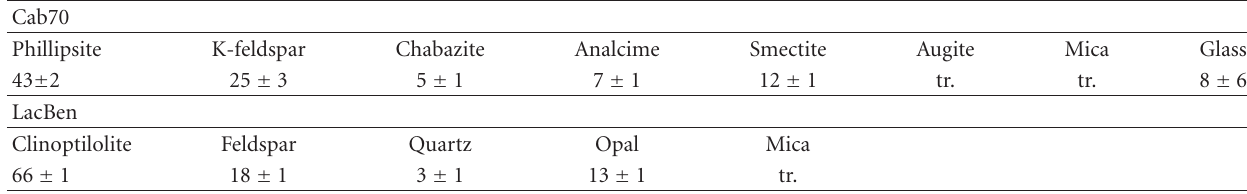
Table 3: Mineralogical composition of Cab70 and LacBen (wt. %, XRPD).